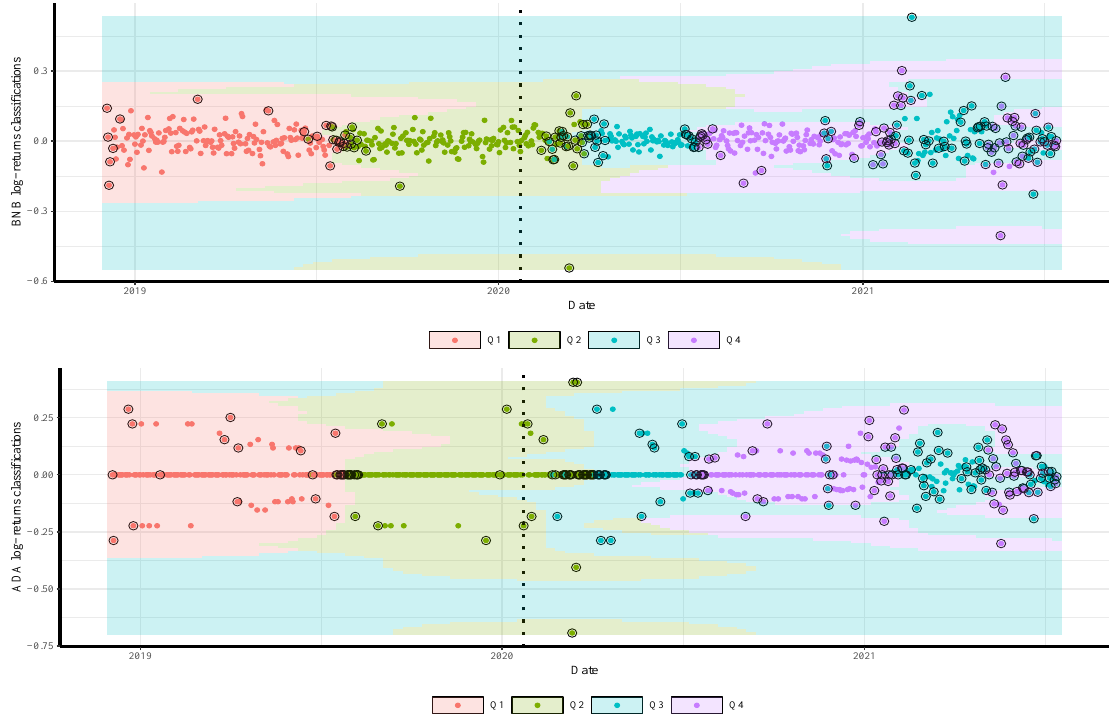
Figure 6. Classifications of BNB ( top ) and ADA ( bottom ) daily returns based on quartiles of daily gold prices predicted by SVM model. The vertical dotted line represents the threshold between the pre-COVID-19 period ( left ) and ongoing COVID-19 period ( right ) to visualize its impact on the cryptocurrency